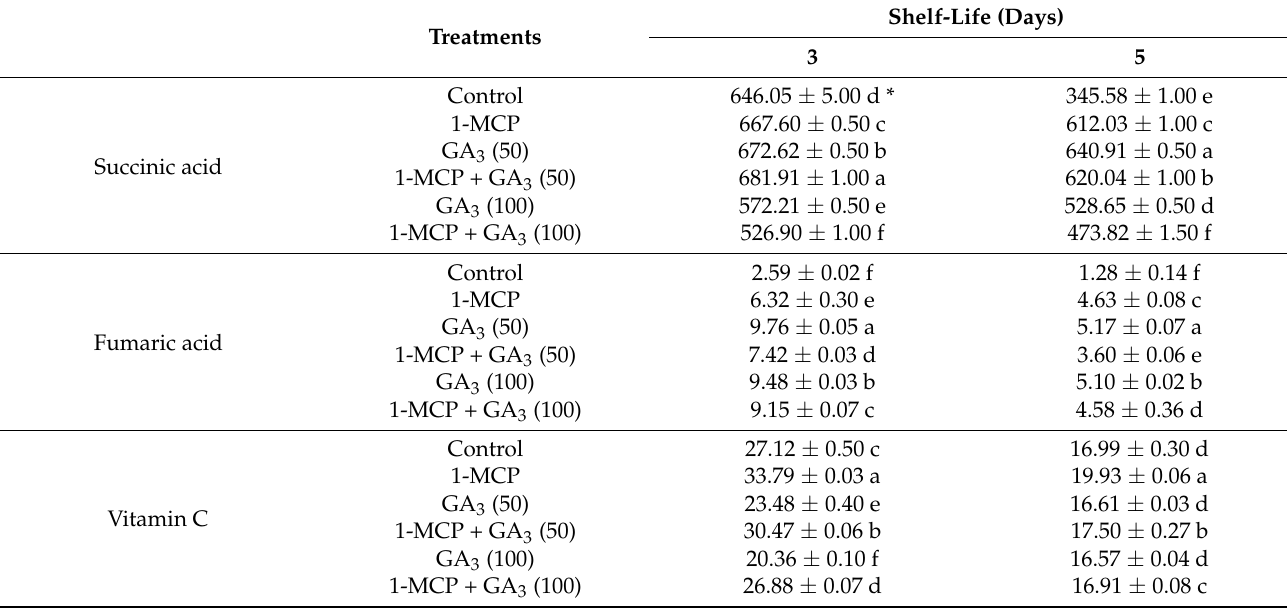
Table 2. Effect of 1-MCP and GA 3 treatments on the succinic acid, fumaric acid, and vitamin C contents during shelf-life of strawberry fruits (mg 100 g − 1